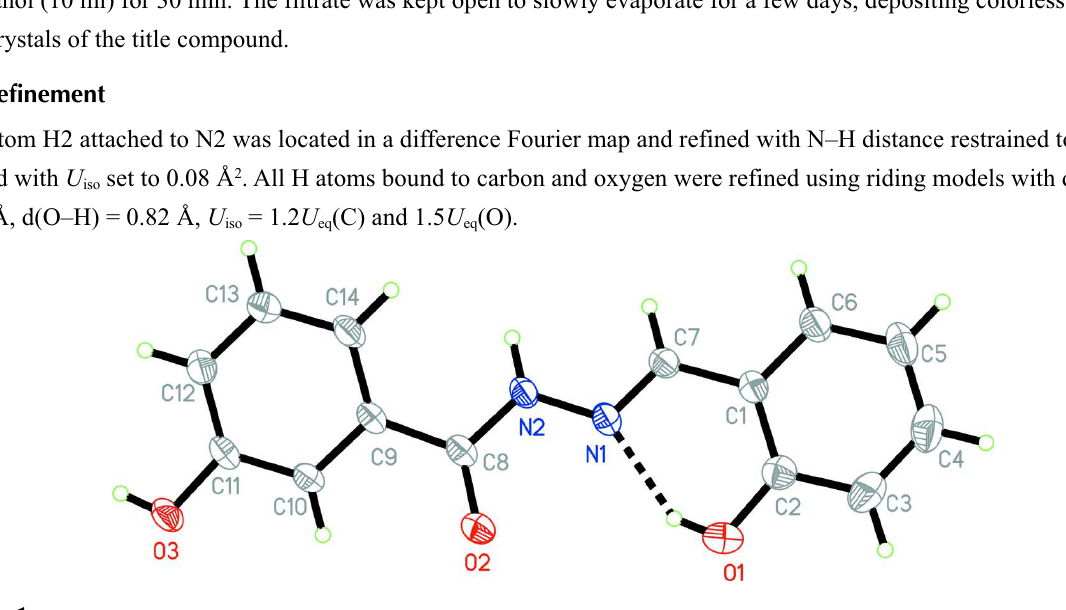
The molecular structure of the title compound, showing the atom-numbering scheme and 30% probability displacement ellipsoids. H atoms are shown as spheres of arbitrary